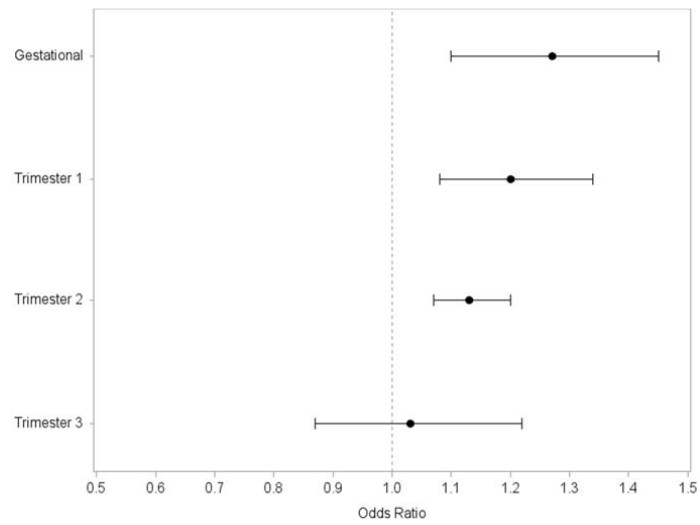
Figure 2. Association between gestational and trimester mean estimates of atrazine exposure in